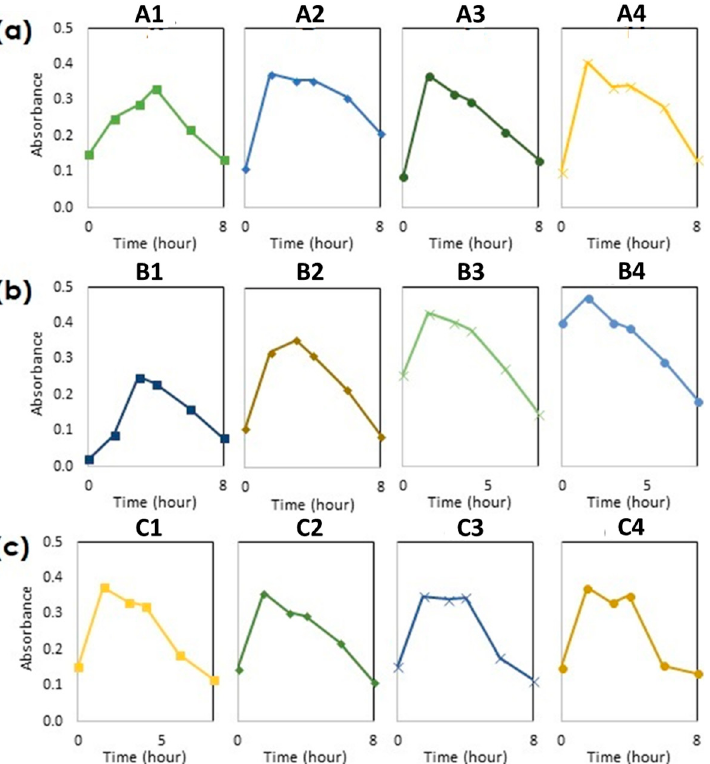
Figure 2. Turbidity changes during fermentation time for different nutrients: ( a ) phosphate, ( b ) fer- rous ion, and ( c ) sulfate.